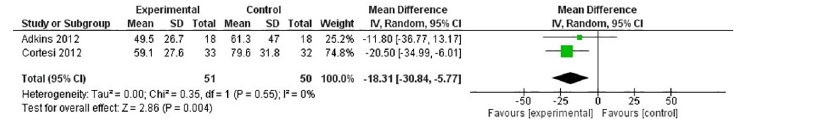
Fig 3. Actigraphy sleep onset latency (minutes) in children with